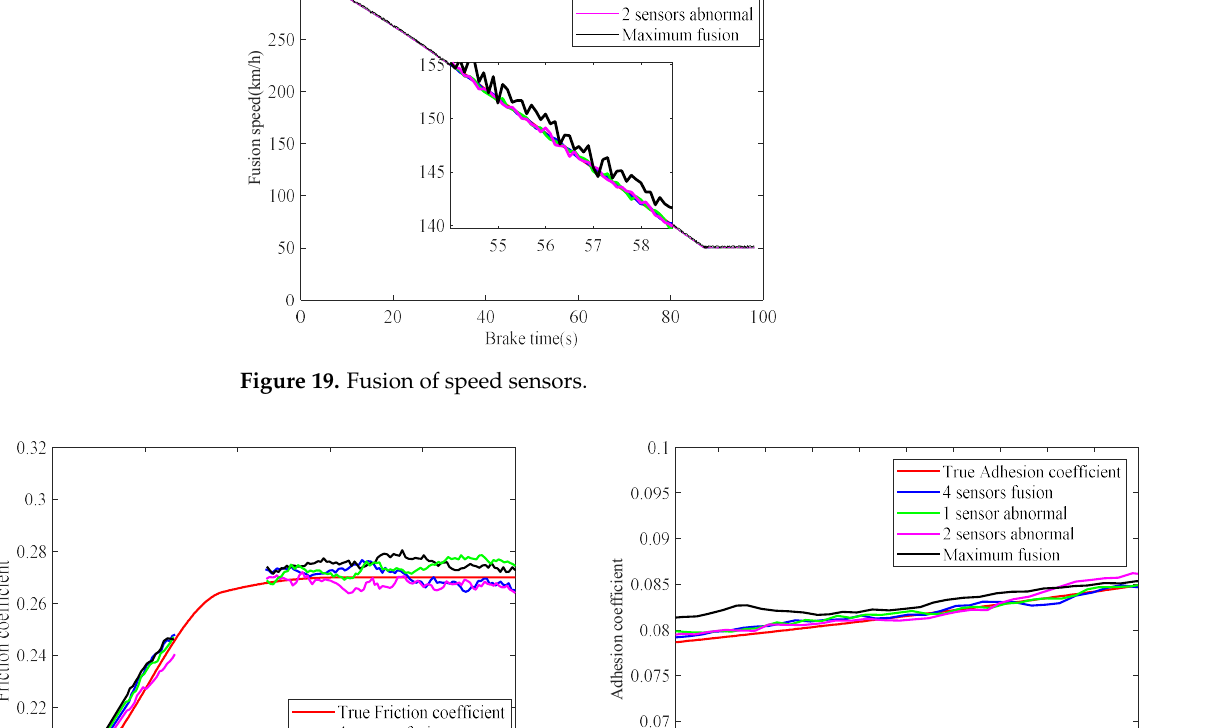
Figure 19. Fusion of speed sensors.